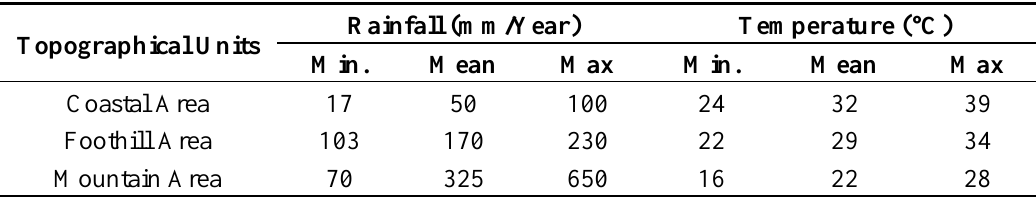
Table 2. Average rainfall and temperature for the main morphological units in the study area